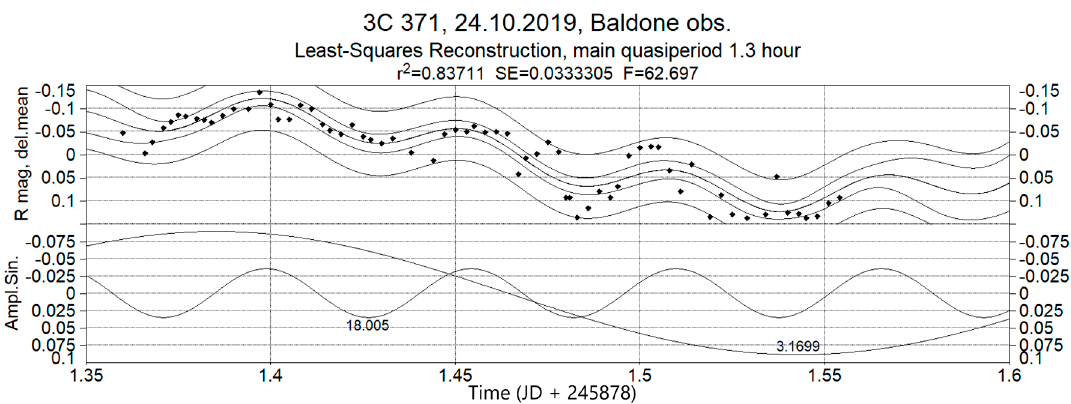
Figure 13. An example of fast brightness variations for 24 October 2019, in the R filter, observed at the Baldone observatory. Shown is a trigonometric polynomial approximation from 1 sinusoid with a period 1.3 h, plus a trend sinusoidal segment (showing a decrease in brightness during the night) with a period 7.6 h. This value (7.6 h) is very close to the 8 h diurnal harmonic, so it most likely cannot be considered a correct result. Approximation parameters: R 2 = 0.83, SE = 0.033, F = 62.70.